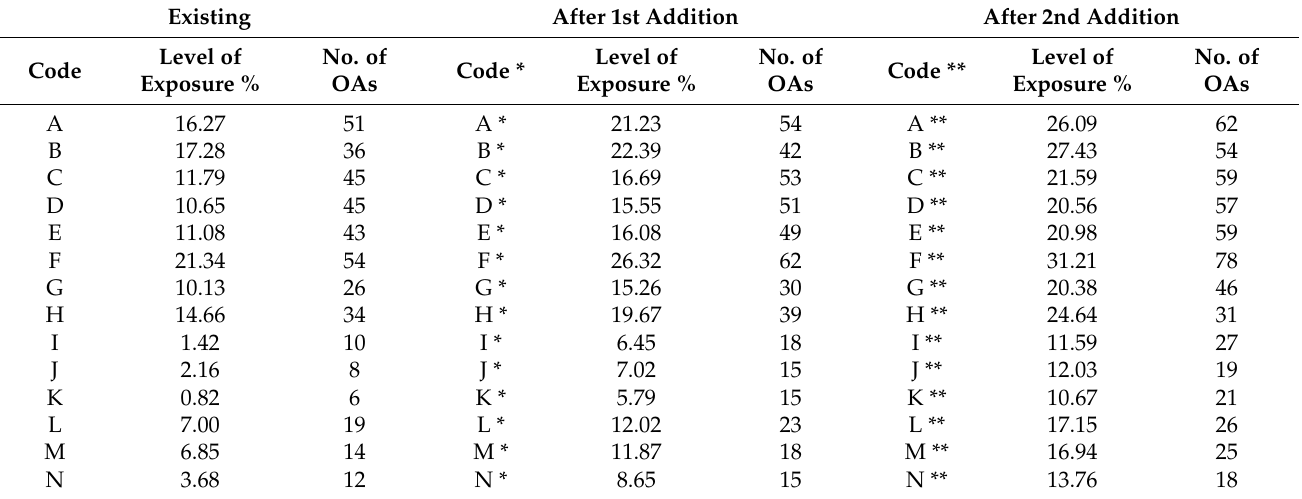
Table 2. Summary of the pictures of areal visual pollution levels represented by the pictorial area and the number of billboard